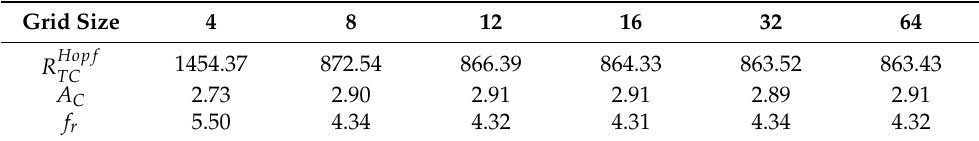
Table 3. Effect of the grid size on the threshold of the Hopf bifurcation in an infinite vertical layer for